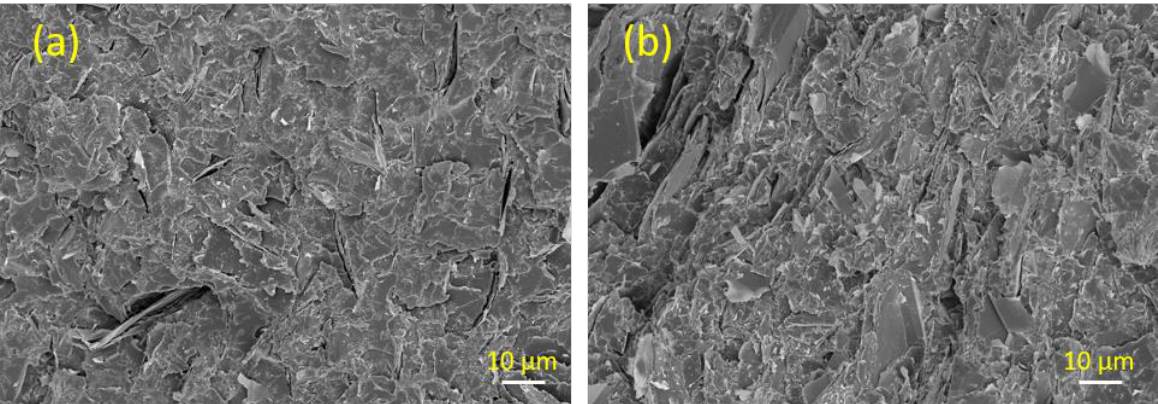
Figure 3. SEM images of cross-sections of GnP/polyester composites containing ( a ) 7.5 wt.% Gr3x versus ( b ) 25 wt.% Gr3x. A cross-section of the GnP/polyester composite prepared with 7.5 wt.% Gr3x loading